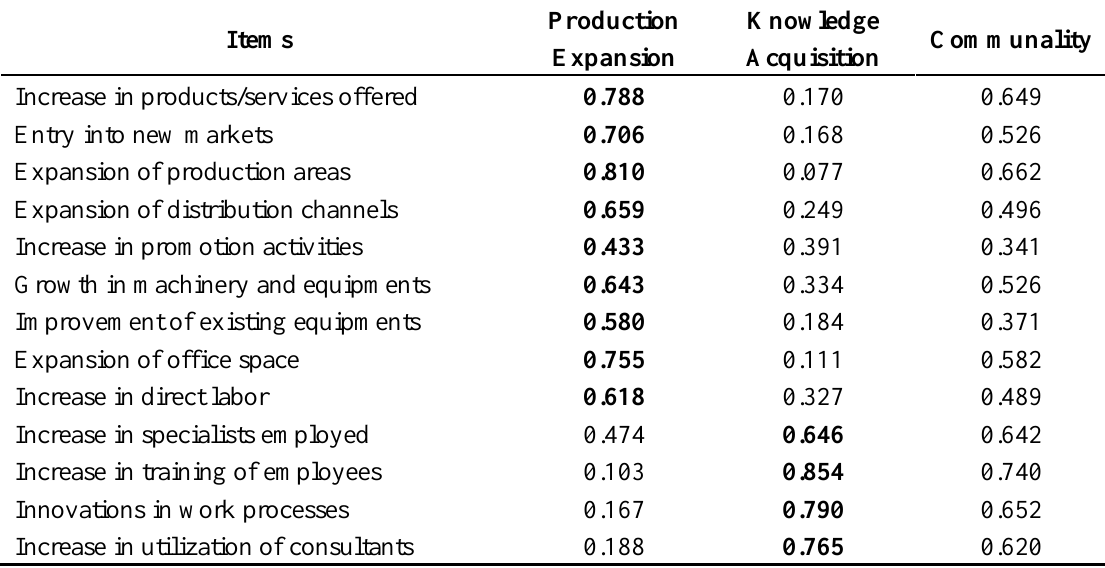
Table 2. Principal components analysis of growth items